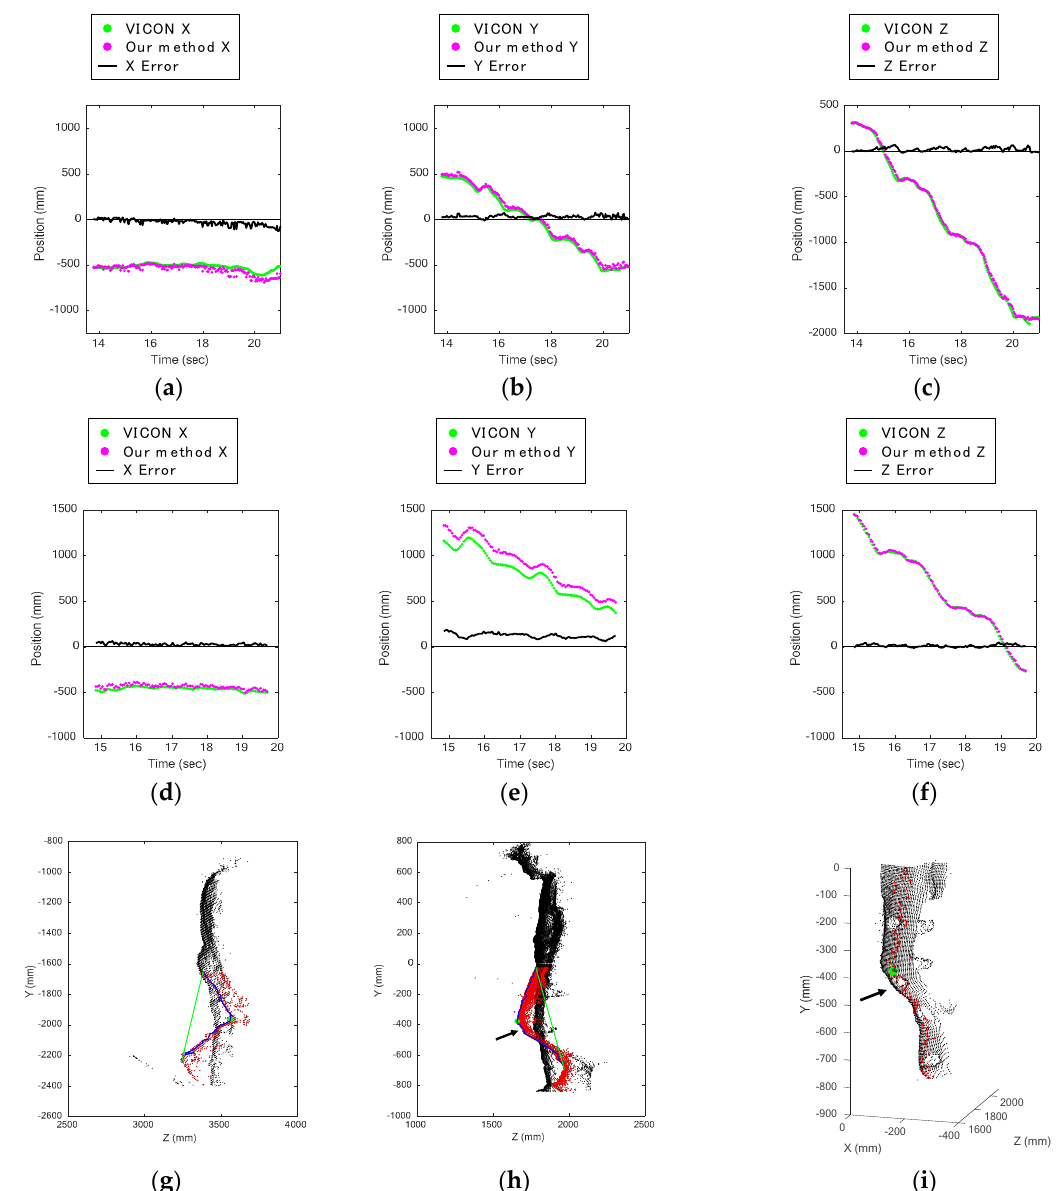
Figure 10. Front silhouette around the knee is round during descent: ( a ) knee displacement on X axis during stair descent captured by upper Kinect; ( b ) knee displacement on Y axis during stair descent captured by upper Kinect; ( c ) knee displacement on Z axis during stair descent captured by upper Kinect; ( d ) knee displacement on X axis during stair descent captured by lower Kinect; ( e ) knee displacement on Y axis during stair descent captured by lower Kinect; ( f ) knee displacement on Z axis during stair descent captured by lower Kinect; ( g ) estimated knee joint position (green dot) and leg area (red dots) during descent captured by upper Kinect; ( h ) estimated knee joint position (green dot), leg area (red dots), and the position of reflective marker of VICON (data hole indicated by an arrow) during descent captured by lower Kinect; ( i ) 3D visualization of Figure 10g; estimated knee joint position (green dot) is located above the position of reflective marker of VICON (hole indicated by an arrow).